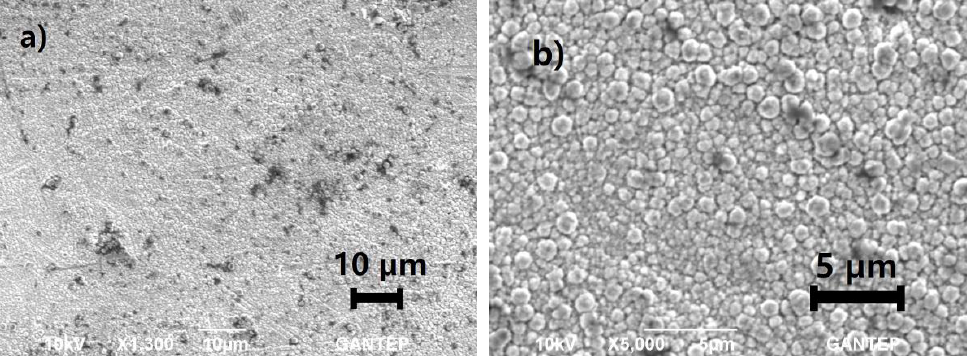
Figure 2. Different magnified SEM images of Zn-Cu coated AZ63 alloy ( a ) 1300× and ( b ) 5000×.